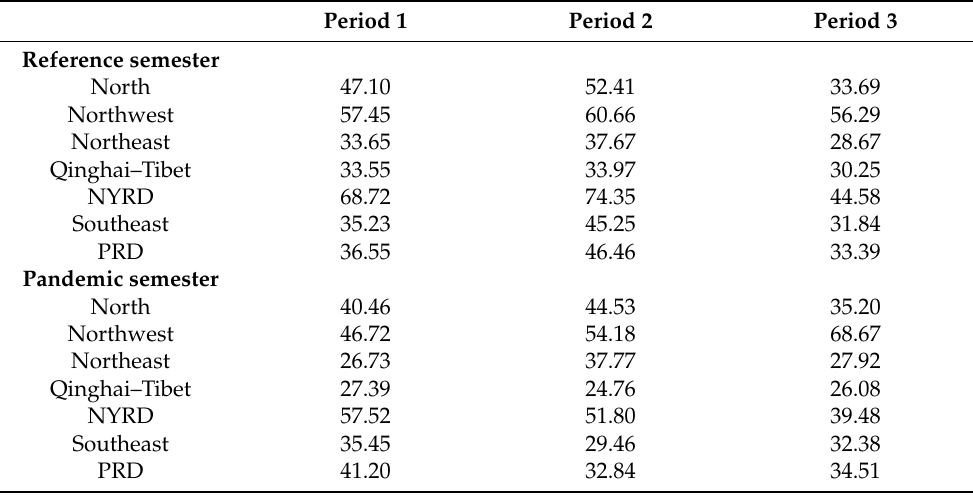
Table 1. Summary statistics of PM 2.5 predictions by cluster during modeling periods (μg/m 3 ).